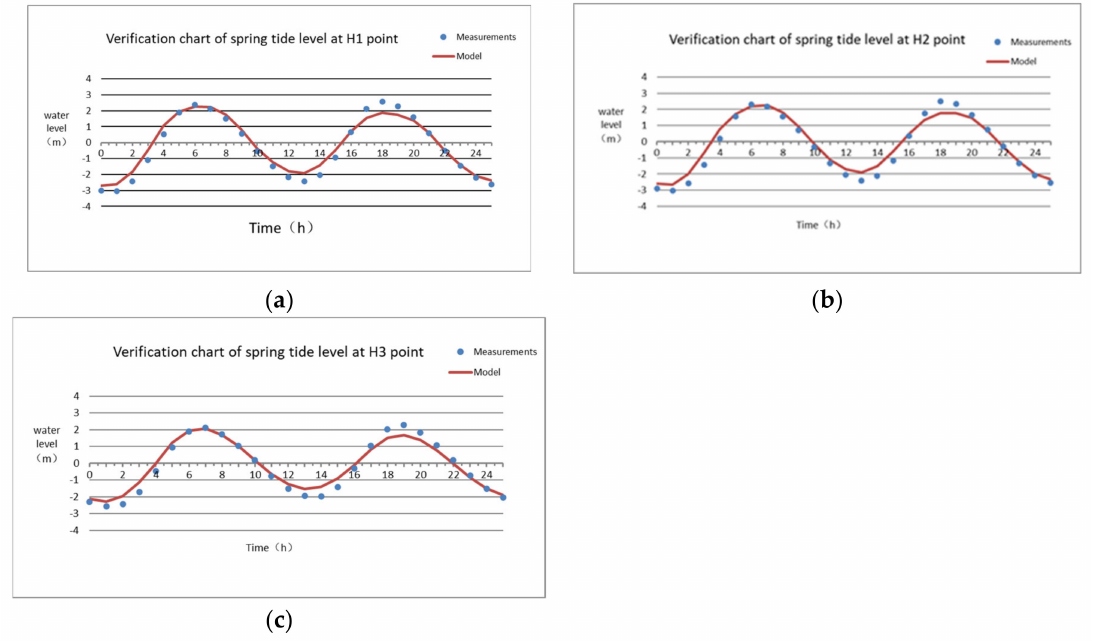
Figure 6. Tide level verification in 2016. ( a ) Verification chart of spring tide level at Point H1; ( b ) Verification chart of spring tide level at Point H2; ( c ) Verification chart of spring tide level at Point H3.